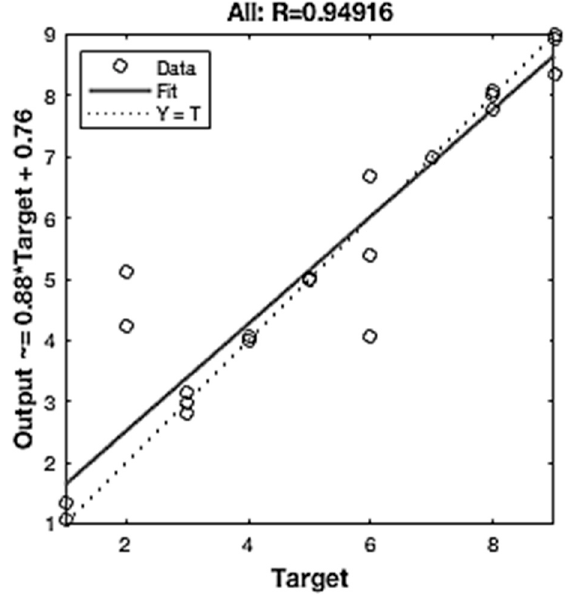
Figure 10. Overall regression outcomes of the proposed MLANN.